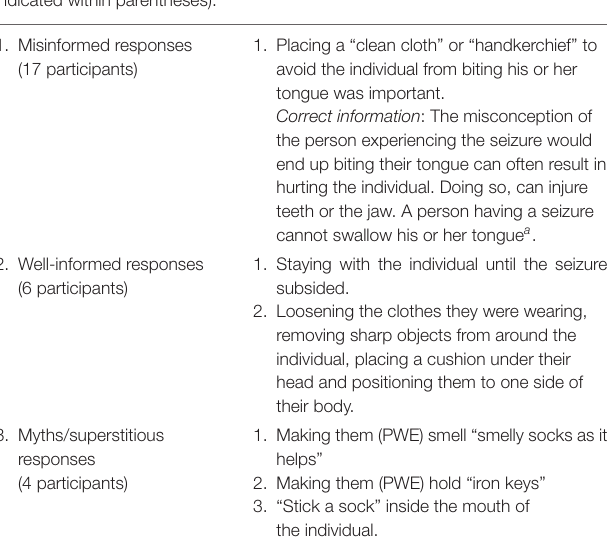
TABLE 1 | Socio-demographic characteristics of the pilot study. Online questionnaire